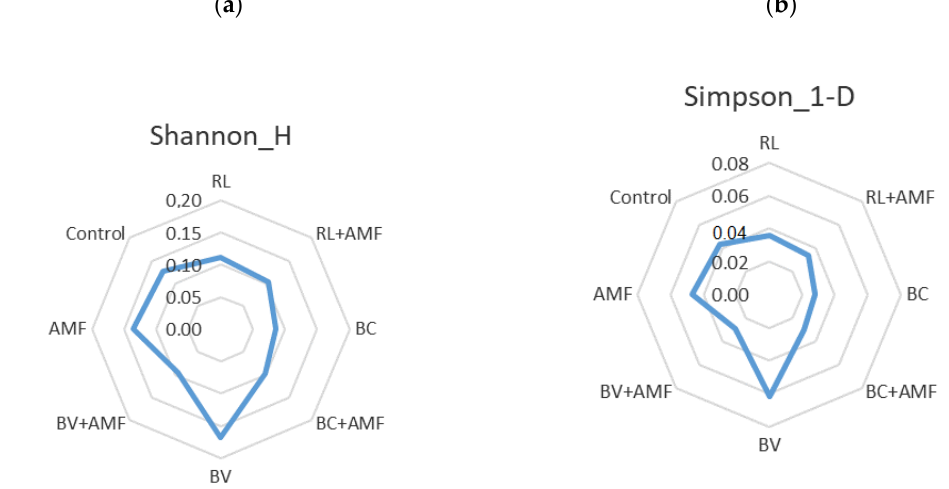
Figure 1. Diversity indices ( a ) Shannon_H and ( b ) Simpson in nodules of fava bean for the different inoculation treatments. Treatment: RL ( Rhizobium leguminosarum ), BC ( Burkholderia cenocepacia ), BV ( Burkholderia vietnamiensis ) and AMF (arbuscular mycorrhizal fungi).